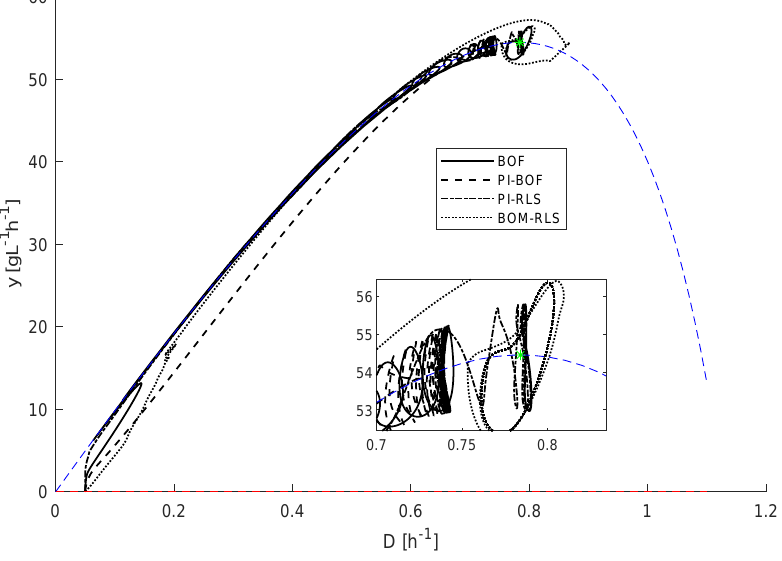
Figure 9. Application of the BOF, PI-BOF, PI-RLS, and BOM extremum seeking methods to optimize biomass productivity of microbial growth represented by model (3) with Monod kinetics—convergence